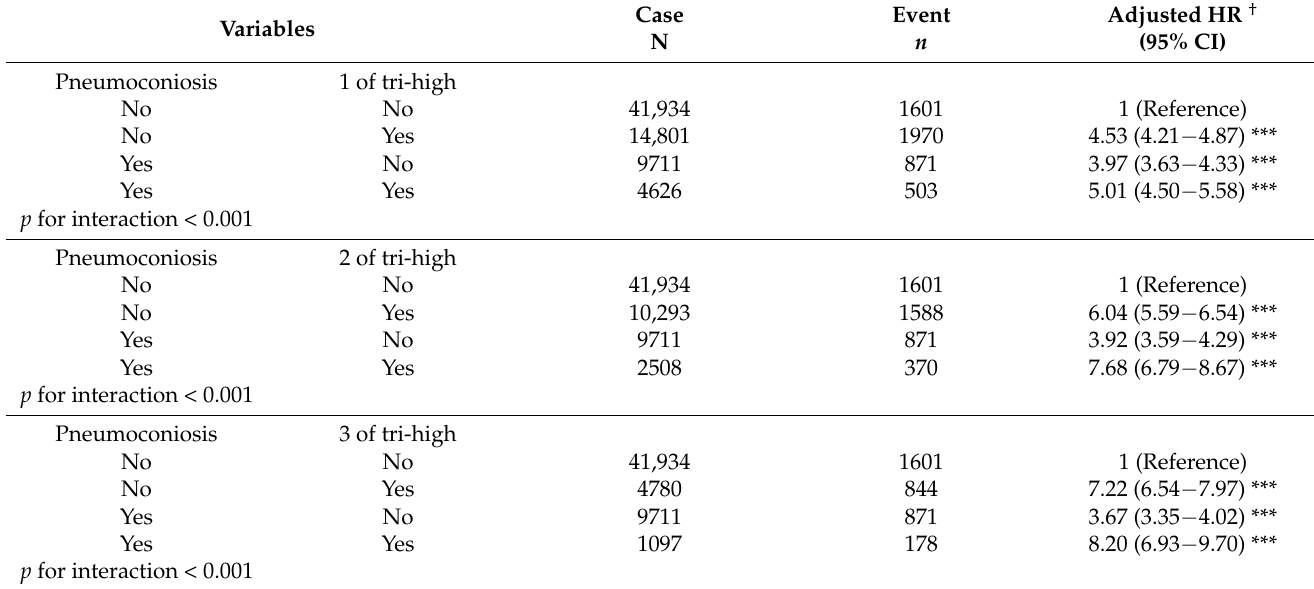
Table 4. Cox proportional hazard regression analysis for the risk of chronic kidney disease-associated pneumoconiosis with interaction of tri-high (hypertension, hyperglycemia, and hyperlipidemia).